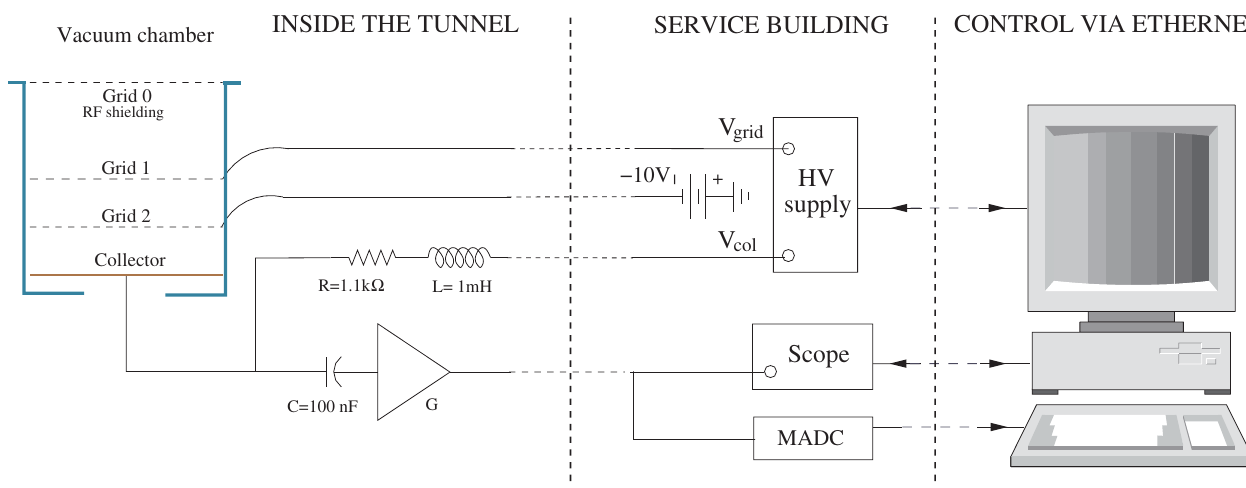
FIG. 2. (Color) RHIC electron detector layout. Part of the electron flux hitting the chamber wall reaches the collector plate. The signal is then magnified using the amplifier (marked with a G ) and transmitted to the scope. Grid 1 is used to filter the energy and bias the collector plate using the high voltage supply. The capacitor between the collector plate and the amplifier protects the latter device from dc current created by the bias voltage. The MADC (multiplex analog to digital converter) digitally reports the peak electron signals with a frequency of 1